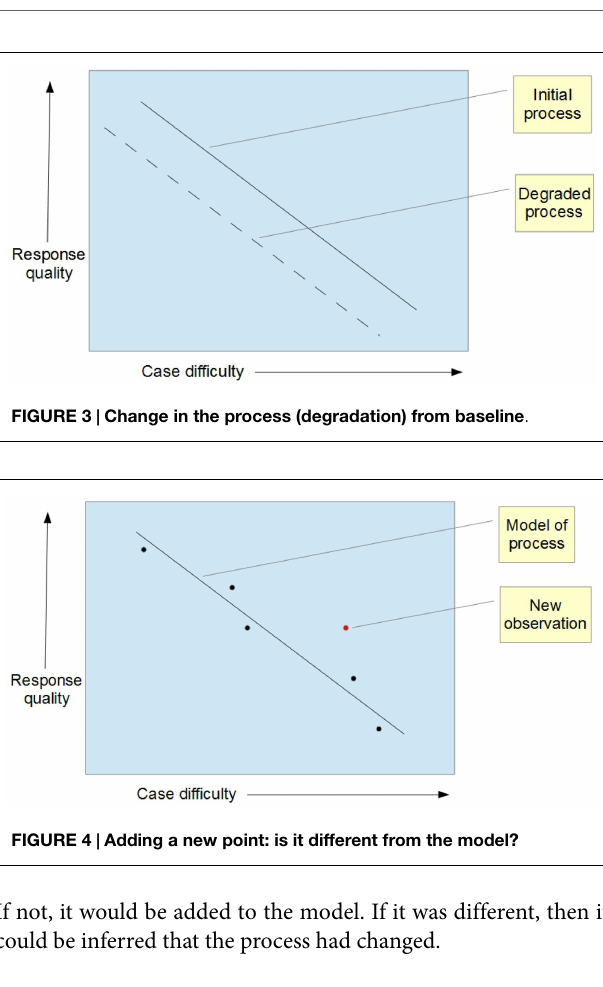
If not, it would be added to the model. If it was different, then it could be inferred that the process had